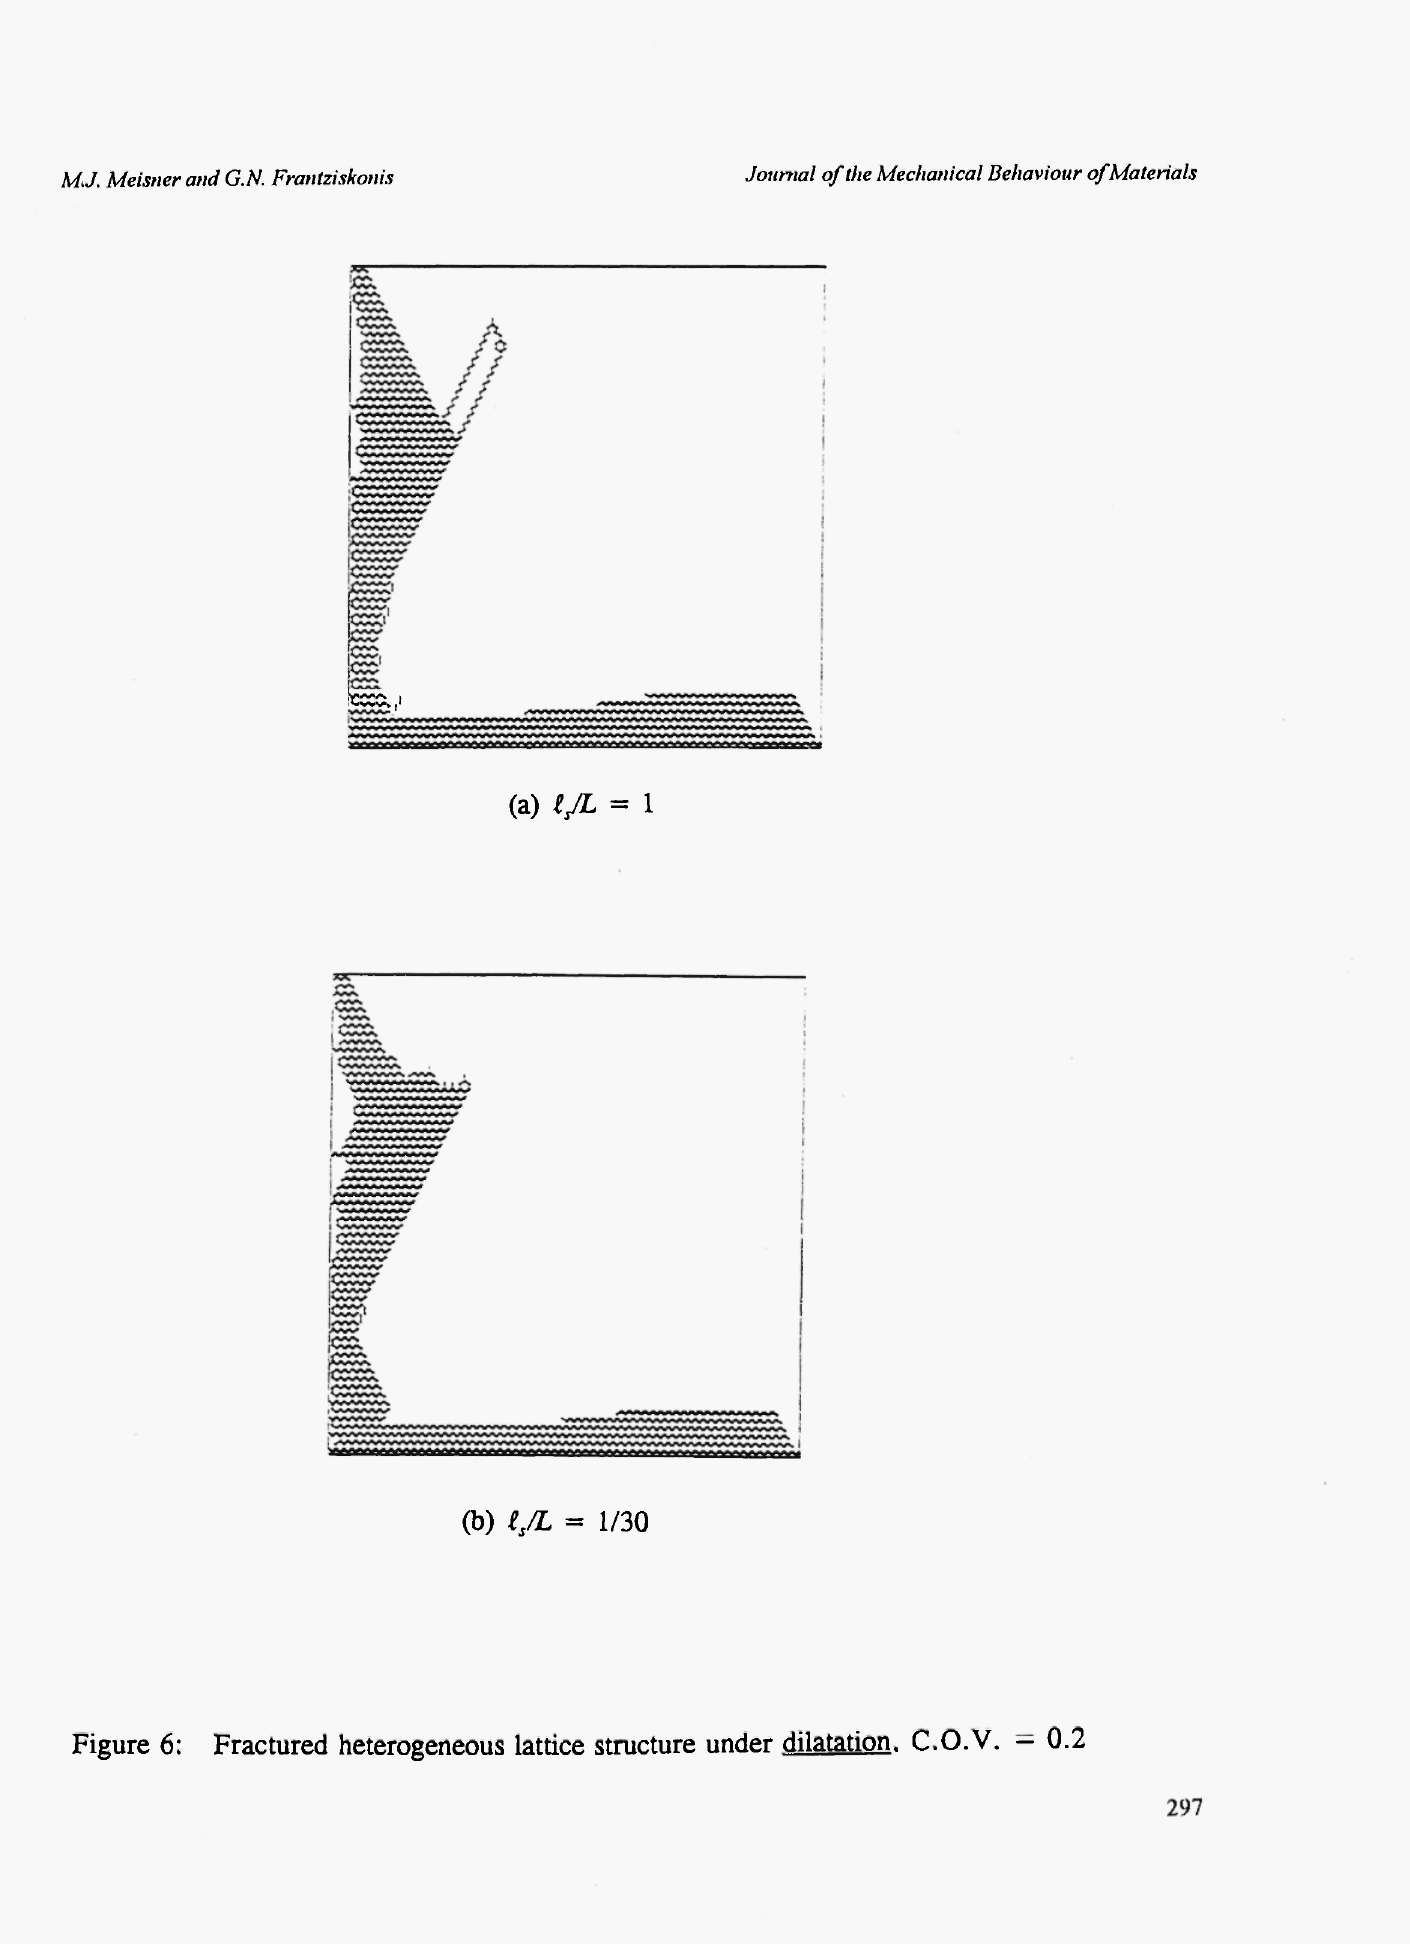
Figure 6: Fractured heterogeneous lattice structure under dilatation. C.O.V. —